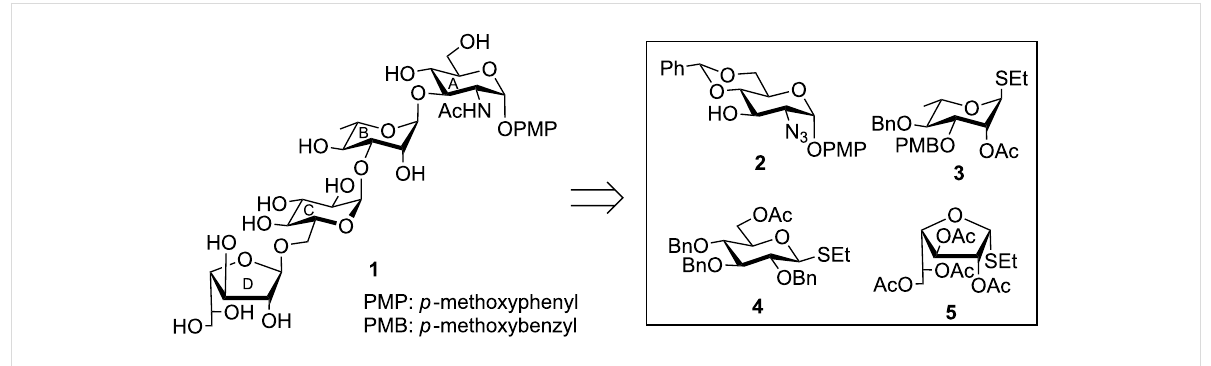
Figure 2: Structure of the synthesized pentasaccharide and its synthetic intermediates.